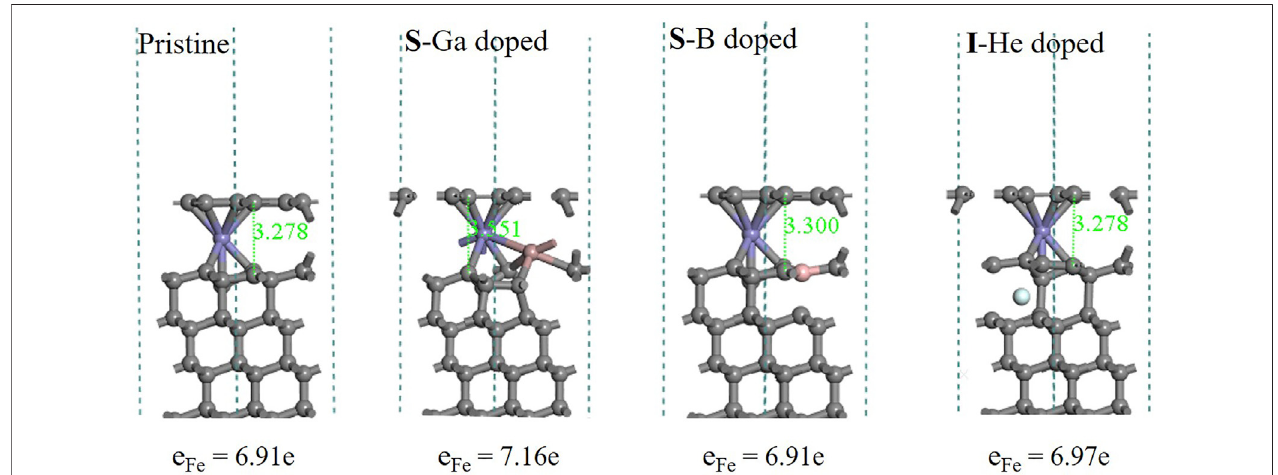
FIGURE 8 | Optimized structures of pristine and doped diamond (111) surfaces with Fe atoms diffused through the top bilayer.